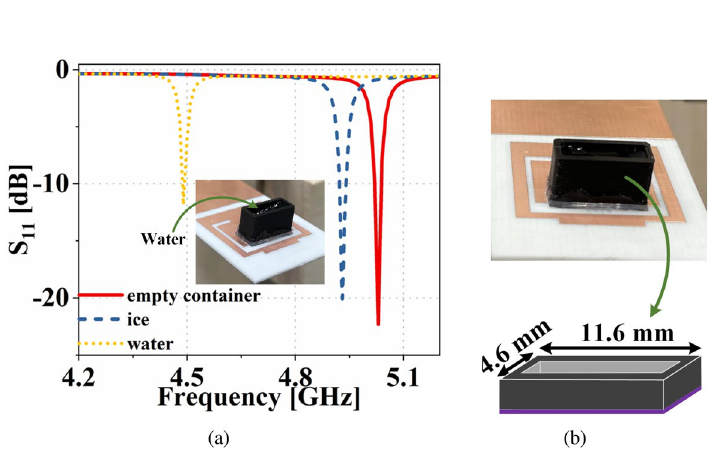
Figure 13. Input reflection coefficient of the dual-functional antenna system in presence of different height of ( a ) ice and ( b ) water inside the container.